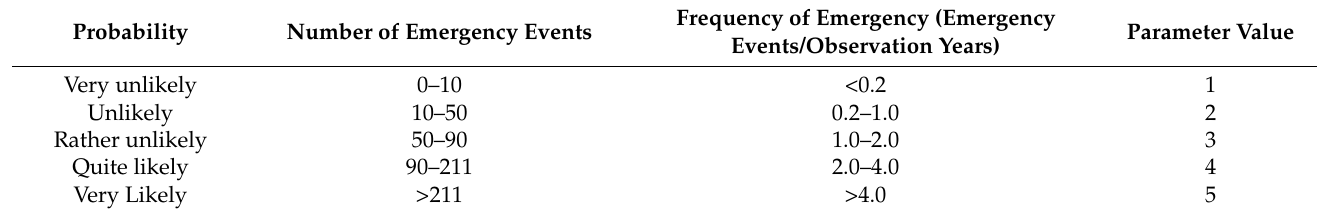
Table 8. The categorization of the extreme events probability